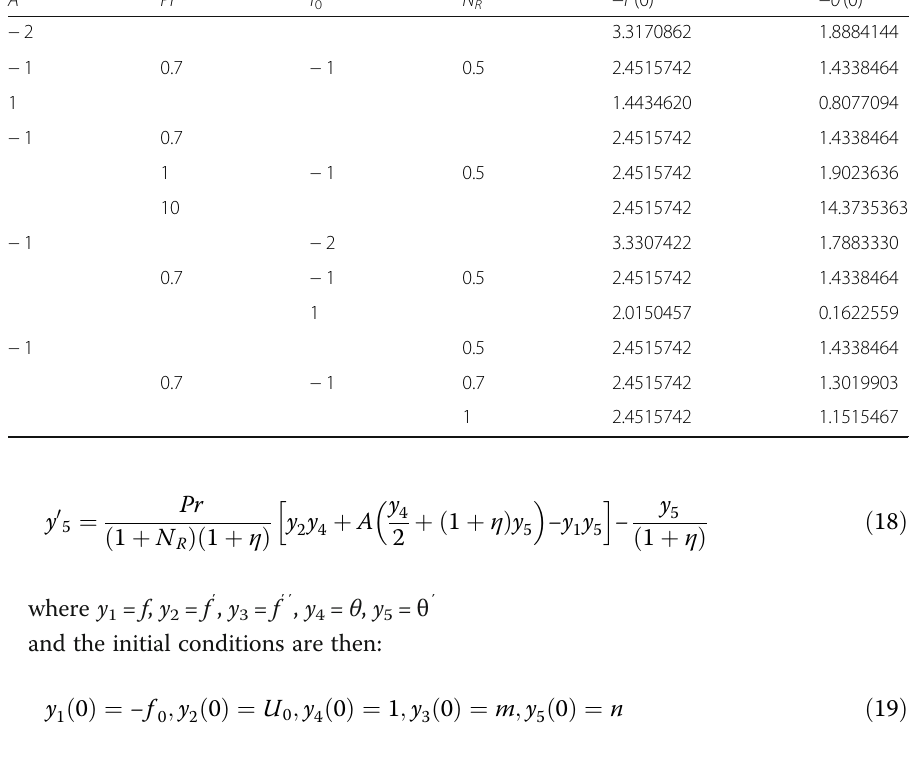
Table 2 Values of − f ′′ (0) and − θ ′ (0) for various values of A , Pr , f 0 , and N R for U 0 = 1 A Pr f